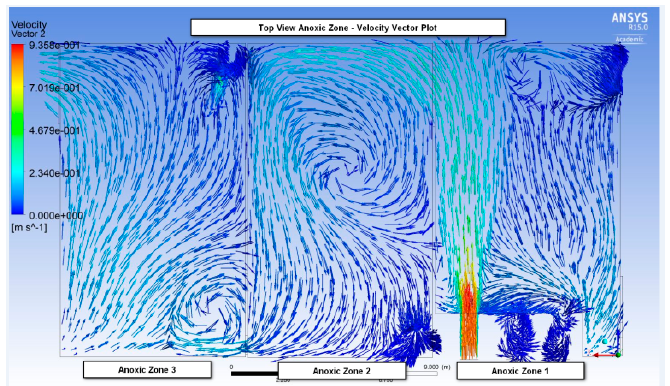
Figure 7. Velocity vector plot 5-m depth.